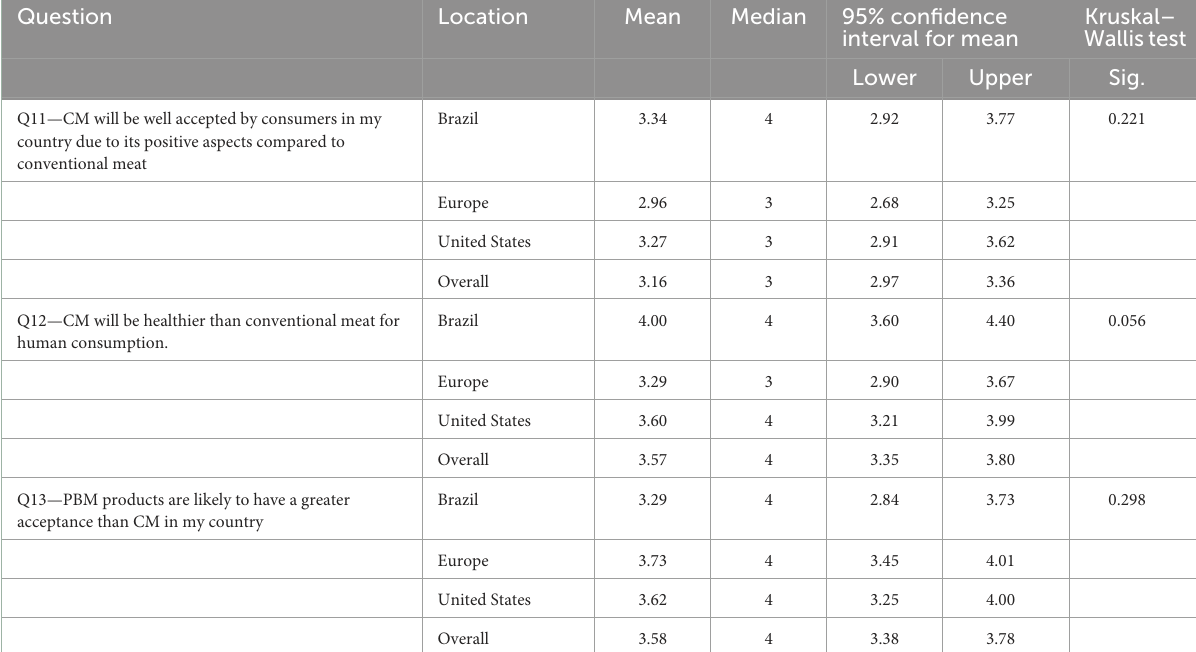
TABLE 4 Analysis for Q11–Q13 regarding consumer acceptance in Brazil ( N = 35), Europe ( N = 56), and the United States ( N = 45) using Likert scale from 1 (strongly disagree) to 5 (strongly agree), as per interviews from August to October, 2021. Question Location Mean Median 95% confidence